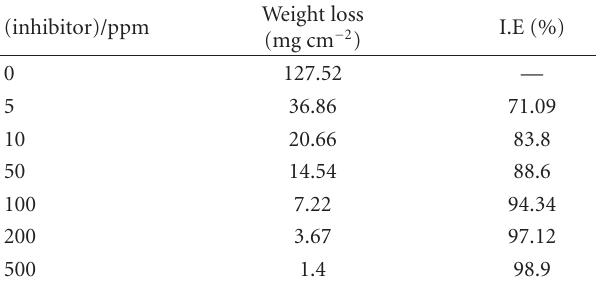
Table 3: Corrosion parameters for mild steel in 1M HCl in the absence and presence of di ff erent concentrations of the inhibitor at 30 ◦ C by weight loss measurements.